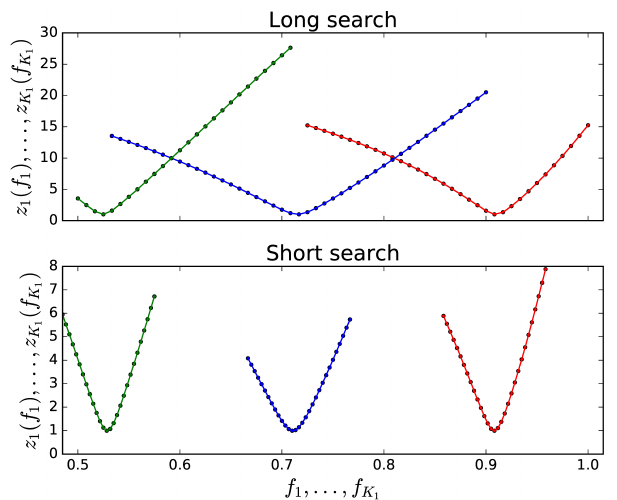
Fig. 2.— Model 19 long and short search periodograms for Table 3 data. Colours for z 1 ( f 1 ), z 2 ( f 2 ) and z 3 ( f 3 ) are given in Table 1. The simulated n (cid:63) = 500 time points t (cid:63) a uniform random distribution between 0 and ∆ T =